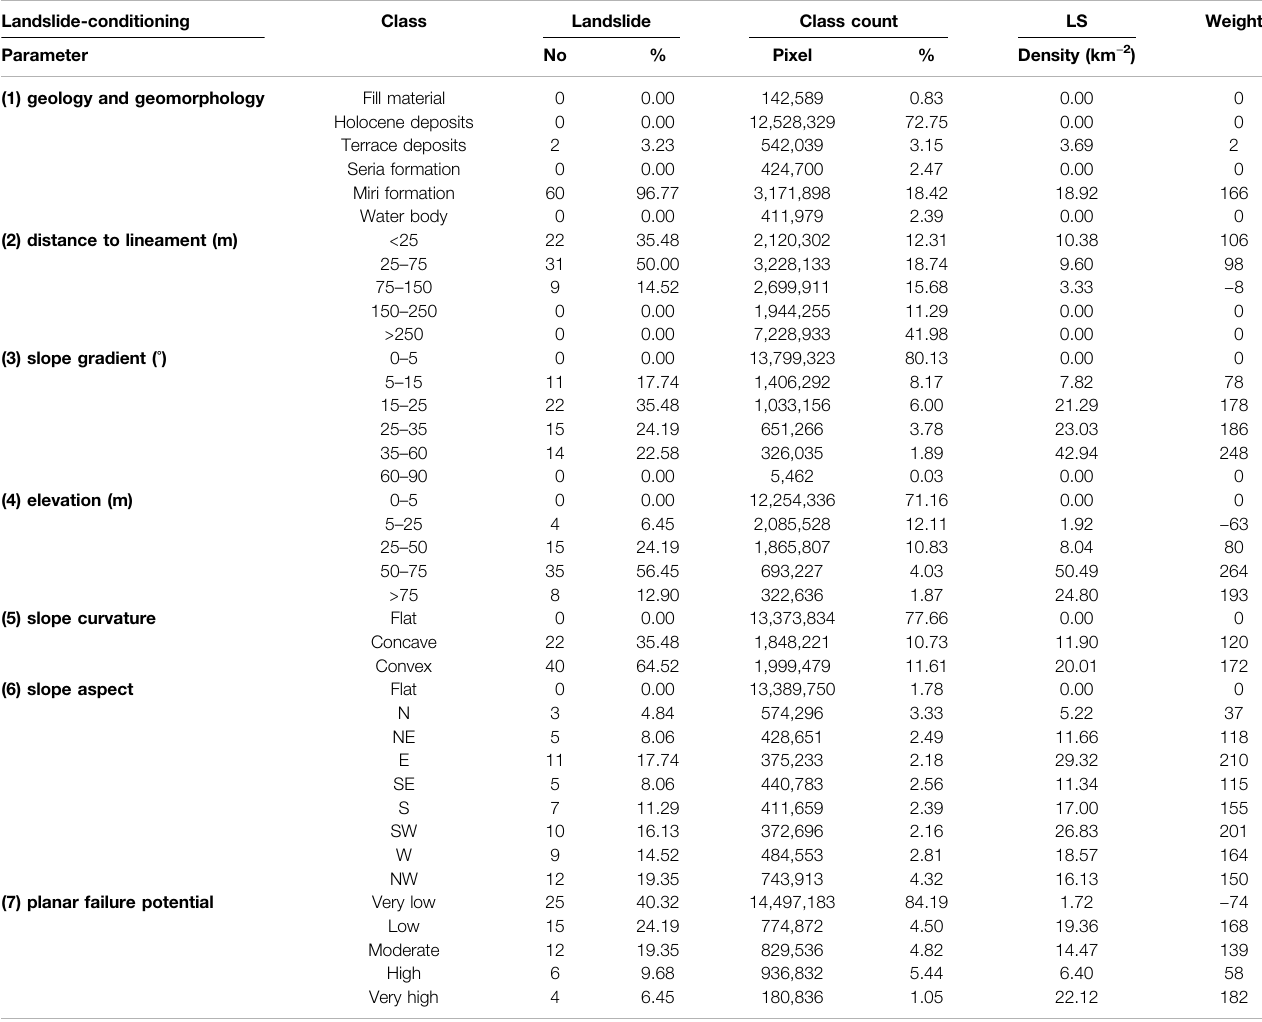
TABLE 2 | The weights and the relationship between landslide-controlling parameters and landslide distribution using the bivariate statistical approach. Only the fi rst six parameters were used in the fi rst analysis. In the second analysis slope aspect was replaced with planar failure potential. Landslide-conditioning Class Landslide Weight